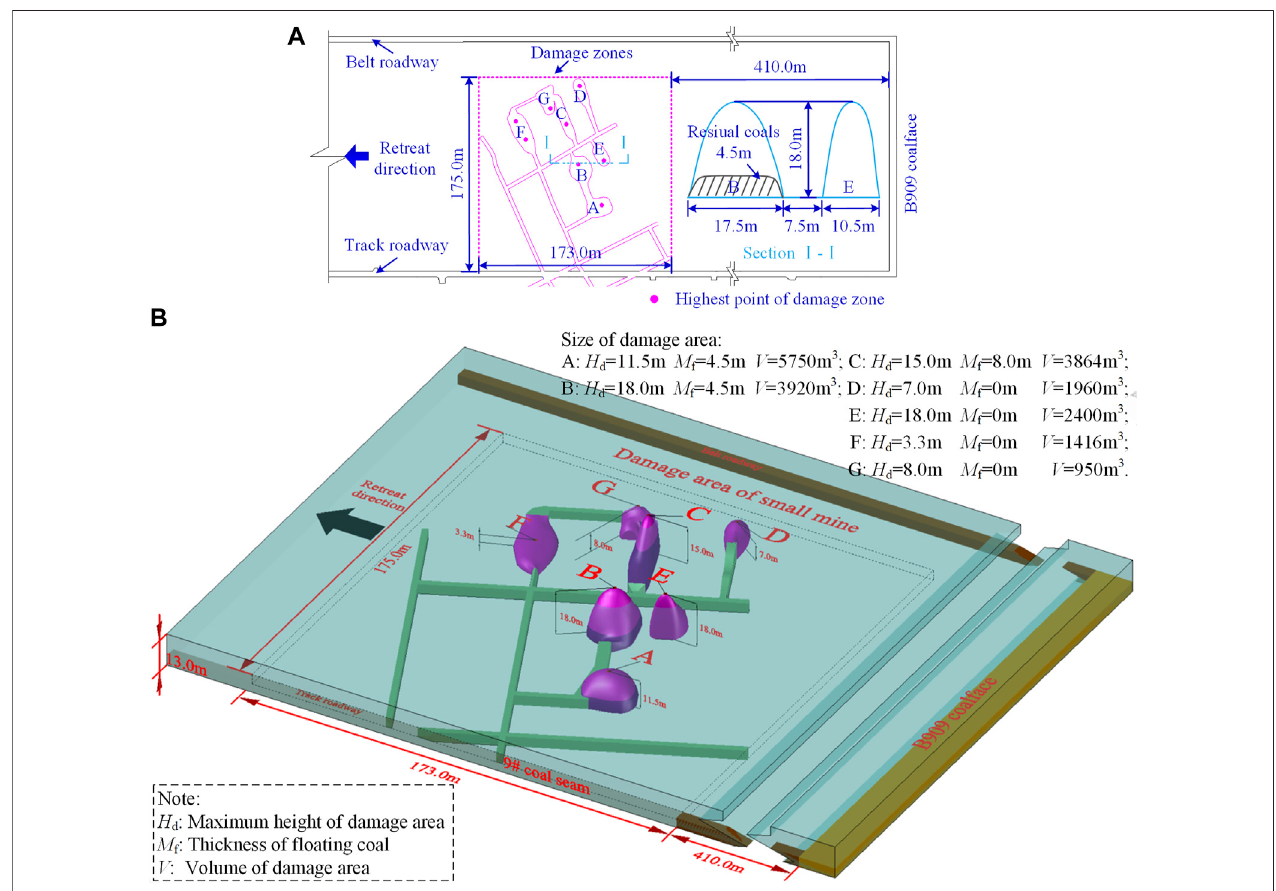
FIGURE 2 | Position of seven damage zones with respect to Panel B909: (A) planform; (B) three-dimensional stereogram.